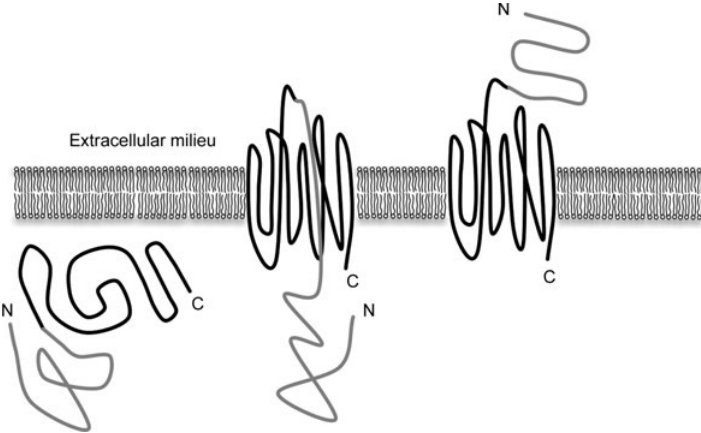
Figure 1 The autotransporter model of Pohlner et al. (9) .